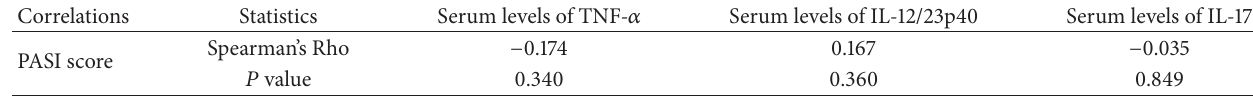
Table 3: Correlation between PASI and cytokines levels evaluated by the Spearman rank correlation.